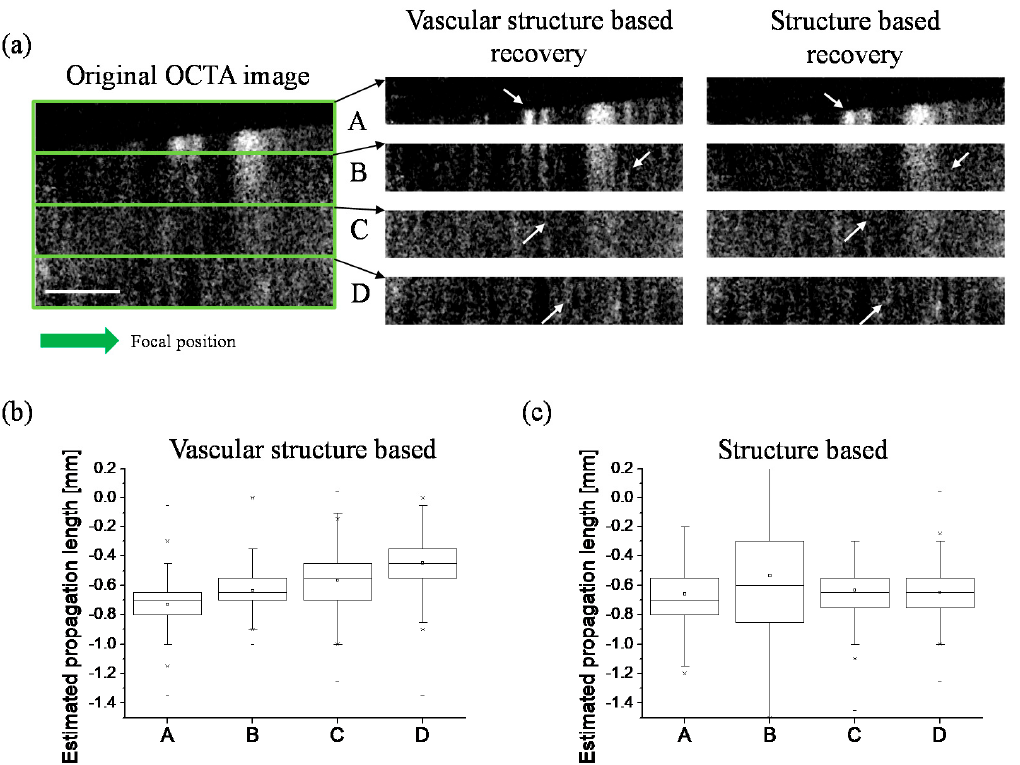
Figure 4. A comparison of the two ways of automatic refocusing of defocused images. ( a ) Automatically recovered OCTA images by blood flow images and structural images, respectively. White arrows indicate noticeable flow signals between two approaches. Distribution of propagation length estimated by ( b ) blood flow images and ( c ) structural images corresponding to each image. The green arrow indicates a focal position. Scale bar is 500 µm.